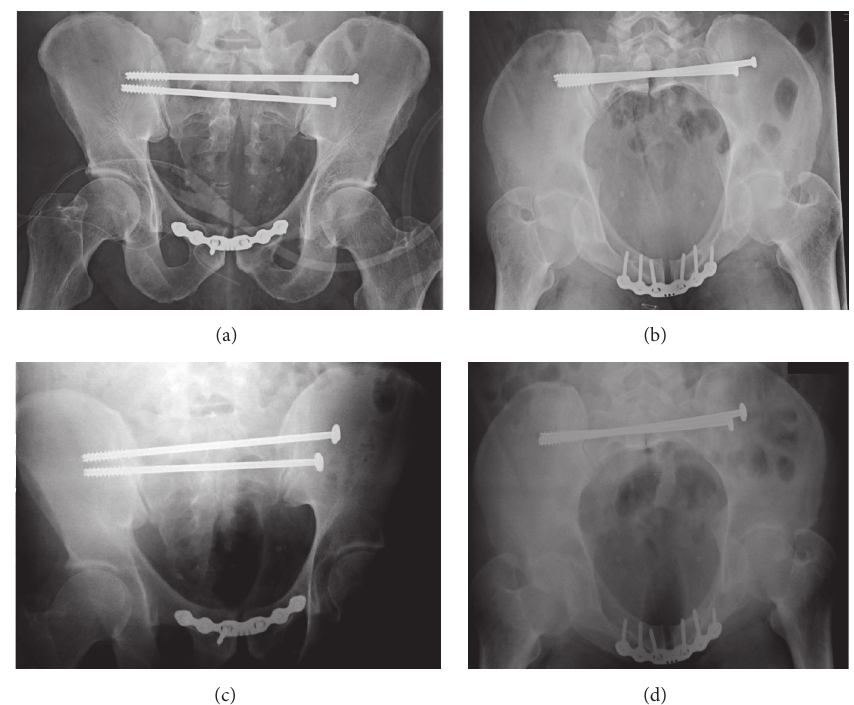
Figure 3: Pelvis (a) anteroposterior and (b) inlet views before using C-clamp and pelvis (c) anteroposterior and (d) inlet views after using